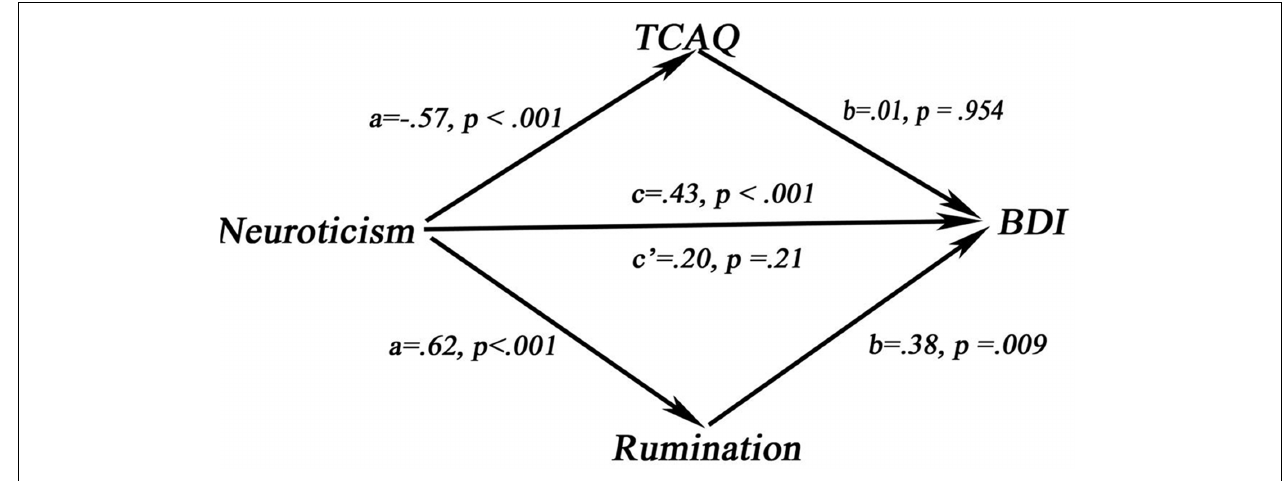
FIGURE 1 | The mediating